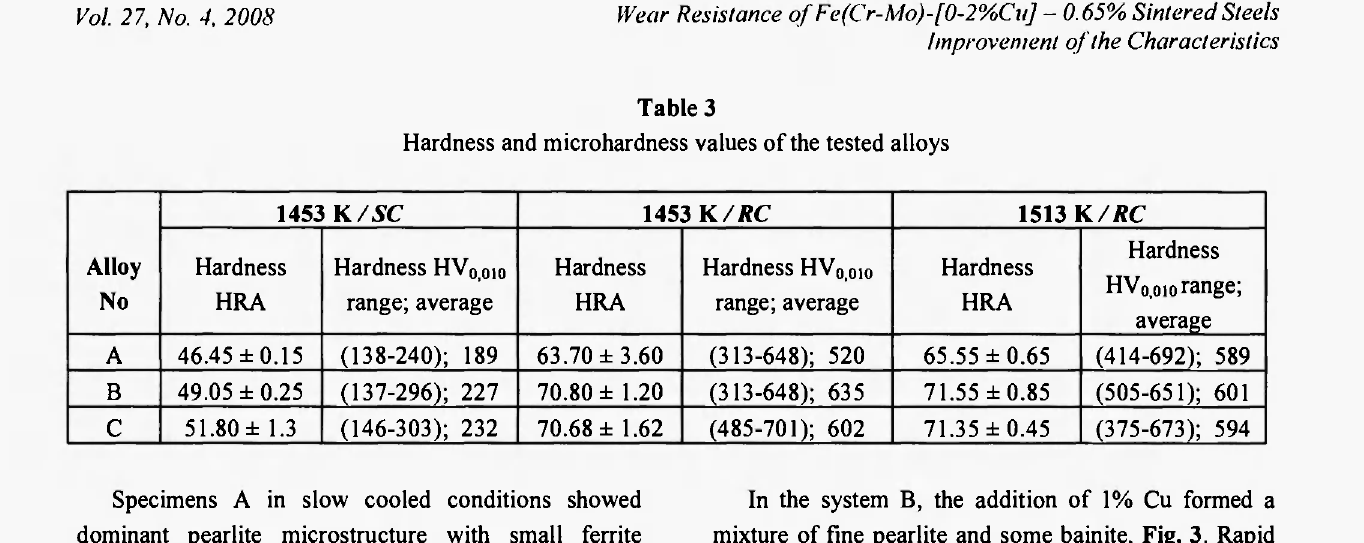
Fig. 3 Microstructures of the specimens Β sintered at temperature of 1453 Κ and followed by slow cooling rate of 0.05 K/s